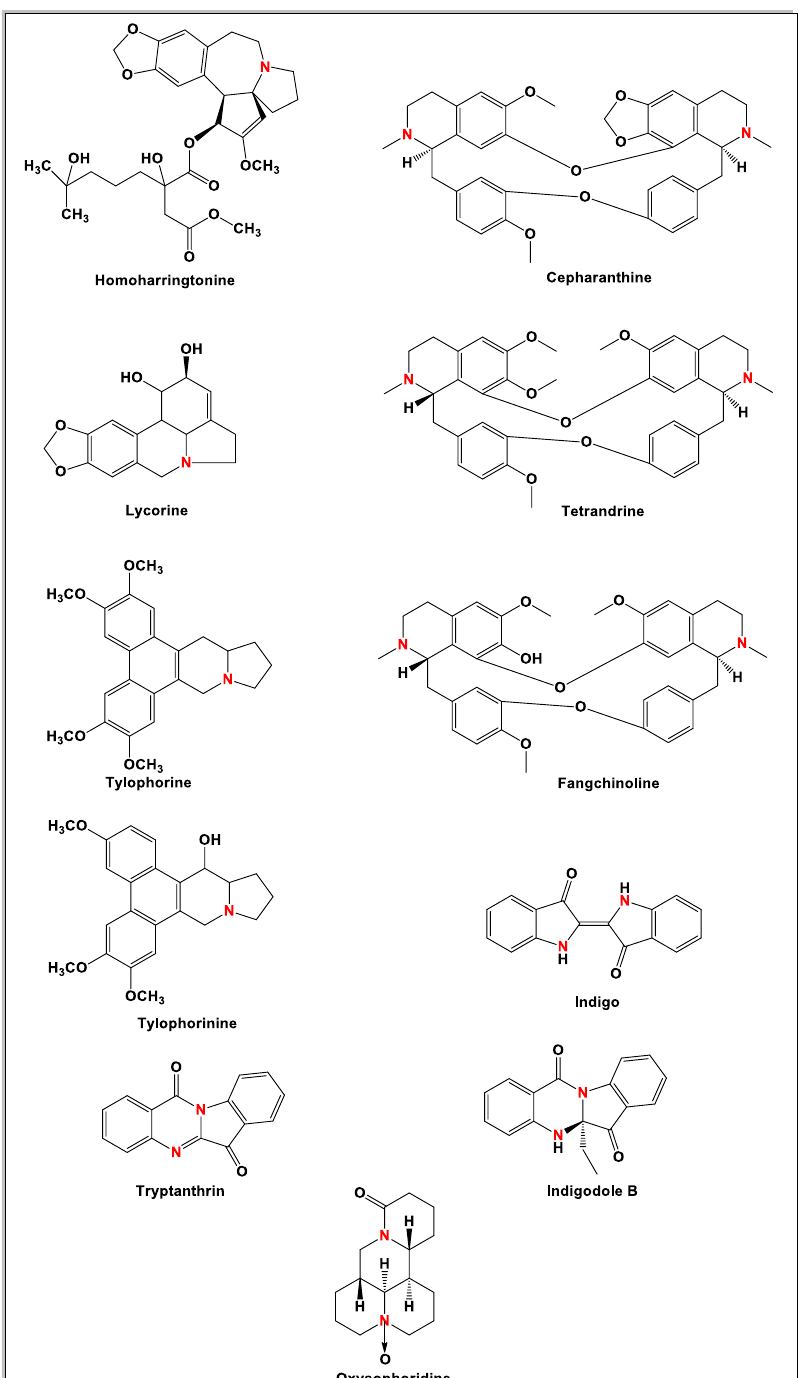
Figure 2. Chemical structures of bioactive alkaloids against coronavirus.